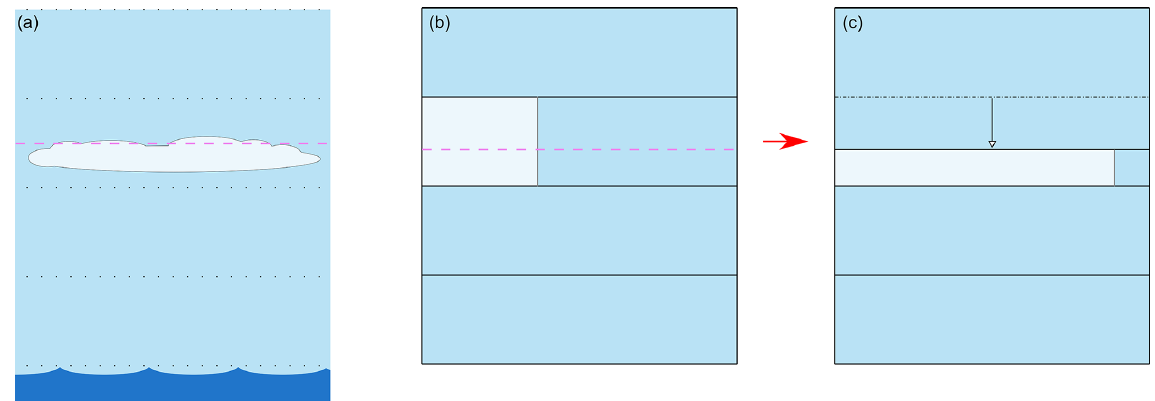
Figure 1. Schematic illustrating the idea behind the new stratocumulus representation method. The pink dashed line represents the temper- ature inversion. Panel (a) is a depiction of the real situation, panel (b) is its representation in the model’s vertical grid, and panel (c) is the same situation on the proposed new vertical